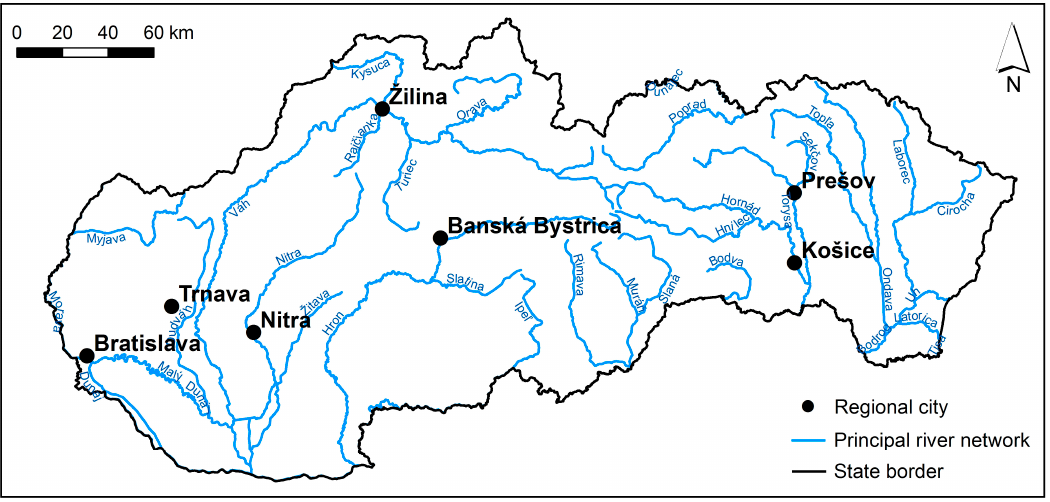
Table 1. Data sources used for processing of flood conditioning